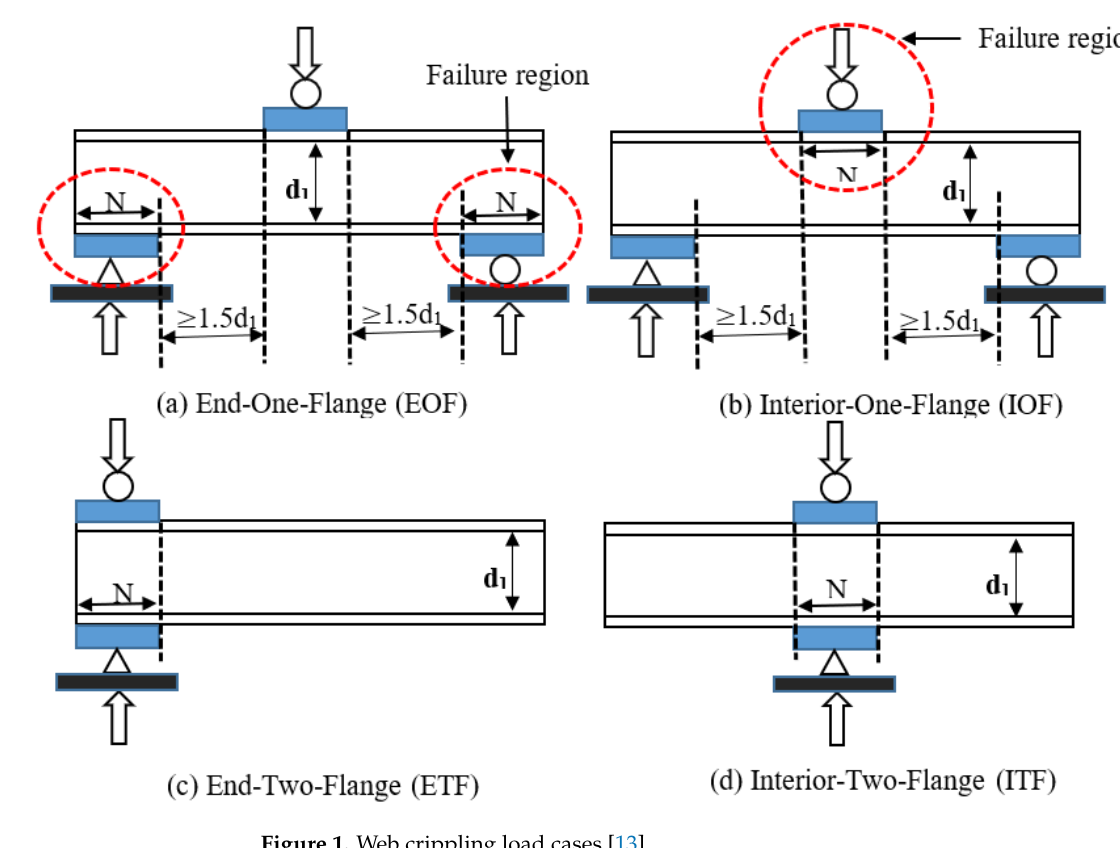
Figure 1. Web crippling load cases